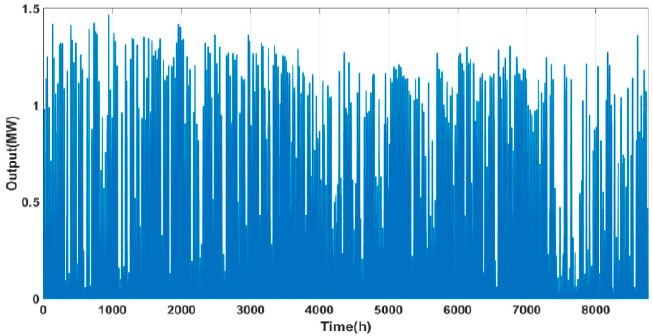
Figure 9. Output pattern of the renewable electrical power source. Table 4. Energy resources data (O&M = operations and